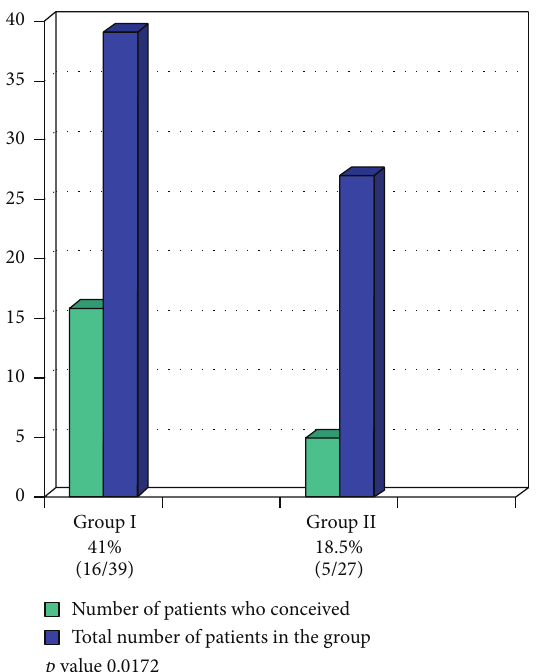
Figure 2: Pregnancy rates in patients receiving progesterone for 3 and 4 days before embryo transfer.